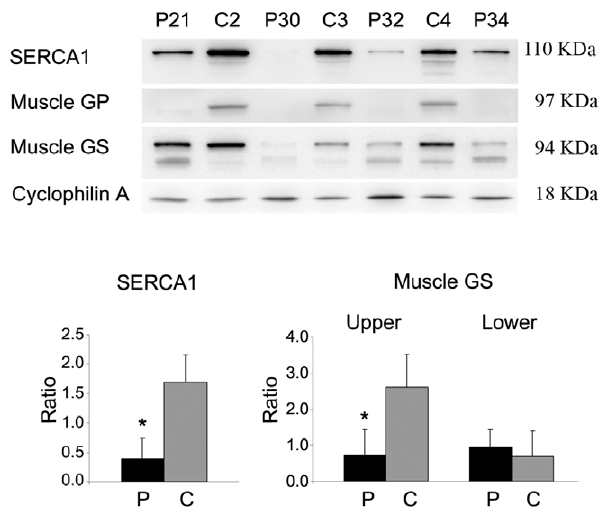
Figure 2. Immunoblotting of patients and controls for SERCA1, muscle GP, muscle GS, and cyclophilin A proteins. Upper panel: immunobloting for the indicated proteins; Lower panel: densitometric analysis for SERCA1 and muscle GS immunodetection. Intensity ratios of protein bands to cyclophilin A are shown as mean 6 SD. Symbol: * p , 0.05; Upper, upper band of muscle GS immunoblotting; Lower, lower band of muscle GS immunoblotting; Patients P21, P30, P32 and P34; Controls C2, C3, C4. P: Patients; C: Controls.